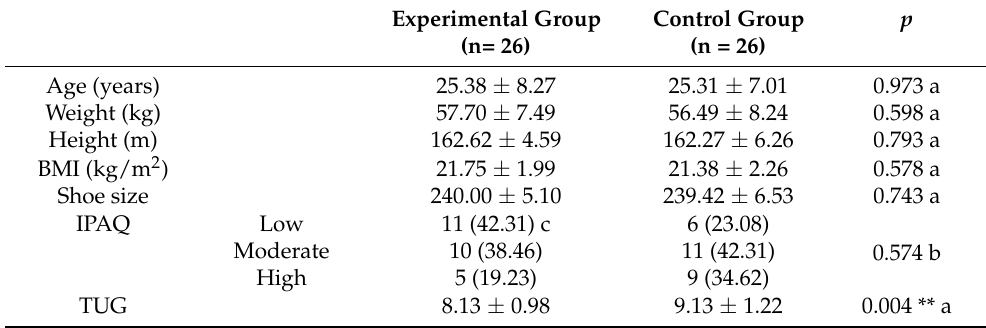
Table 2. Demographic characteristics of the participants (n = 52).